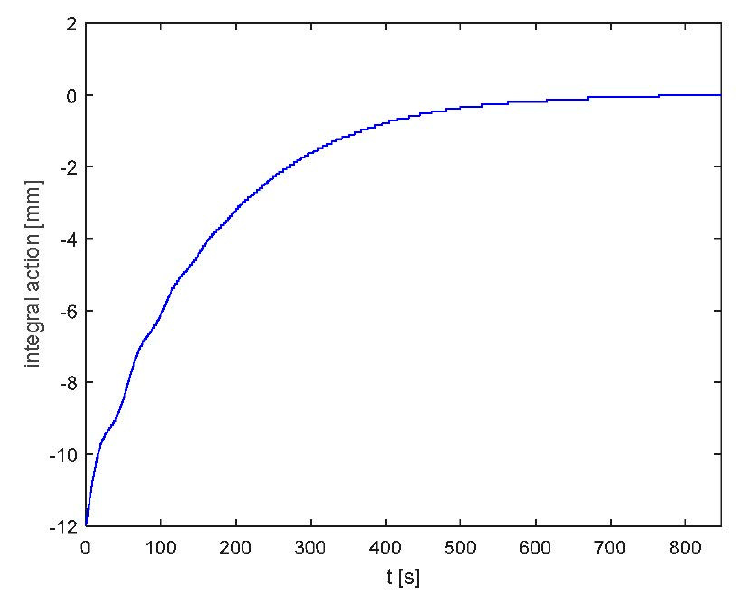
Figure 12. PI control: integral control action evolution.